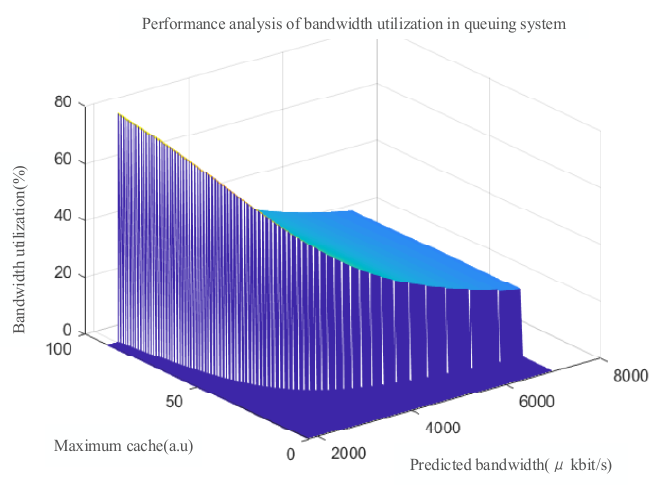
Figure 6. Performance analysis of bandwidth utilization in the queuing system.